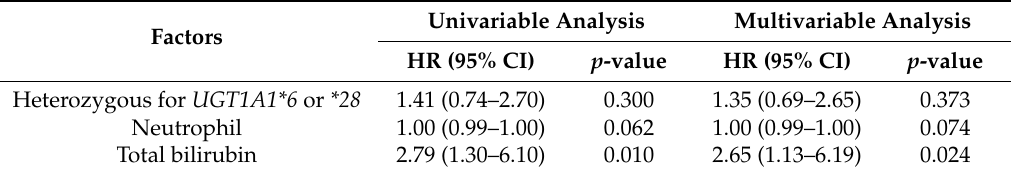
Table 5. Cox proportional hazard analysis of the risk of grade ≥ 3 neutropenia in pancreatic cancer patients receiving modified FOLFIRINOX therapy.